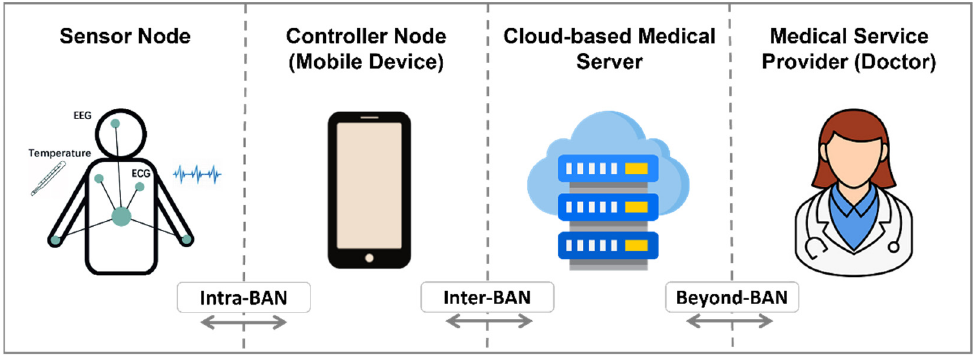
Figure 1. WBAN system model overview.